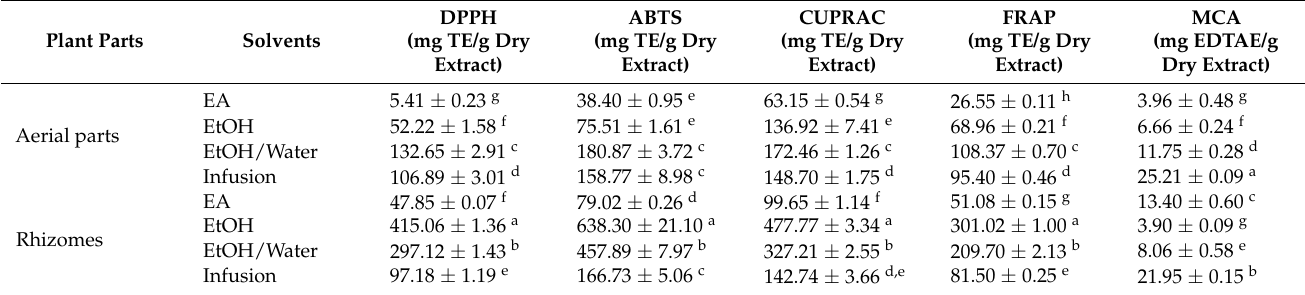
Table 3. Radical scavenging (1,1-diphenyl-2-picrylhydrazyl (DPPH) and 2,2 (cid:48) -azino-bis(3